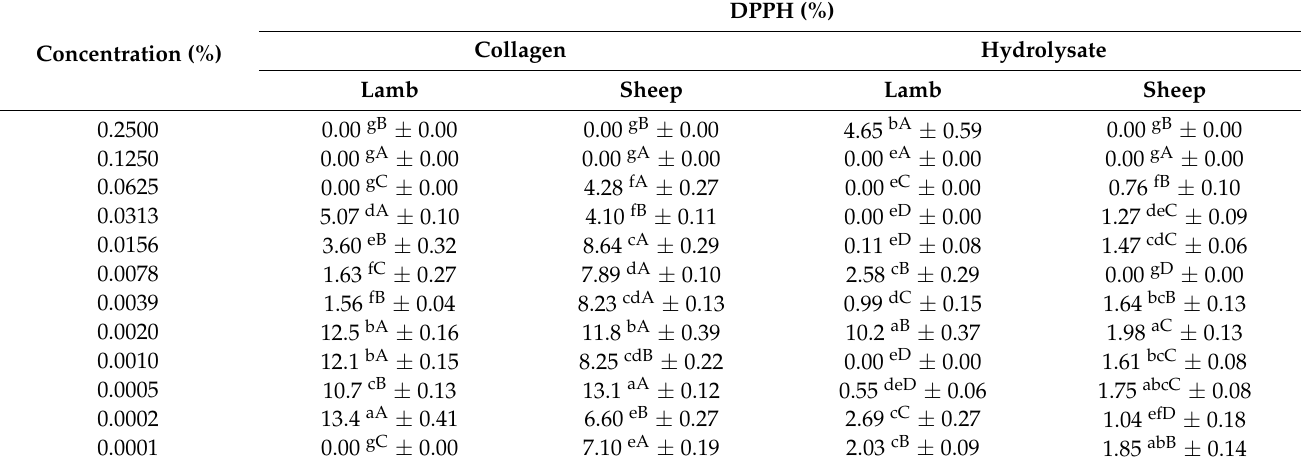
Table 2. Antioxidant activity (DPPH, %) of collagens and hydrolysates obtained from sheep slaughter